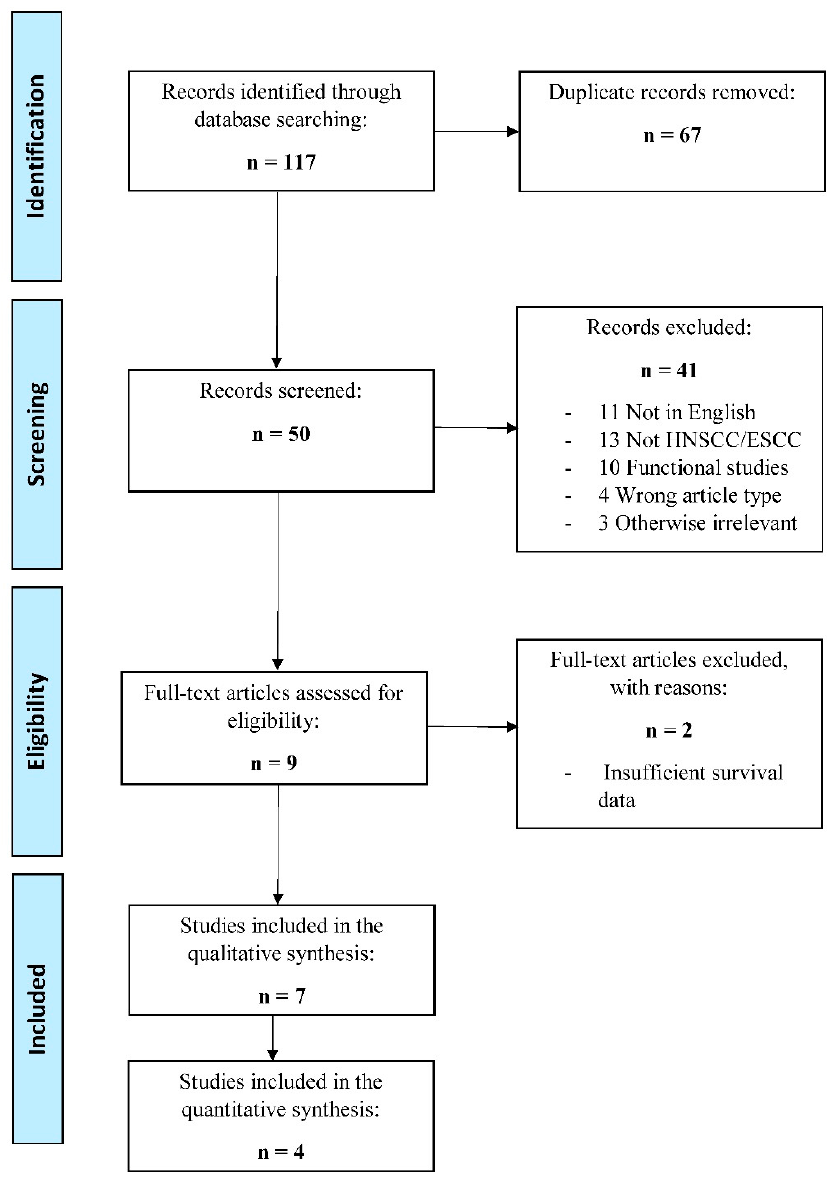
Figure 1. Flowchart diagram of literature search and selection. Irrelevant article types and other exclusion criteria are listed in Table 1.